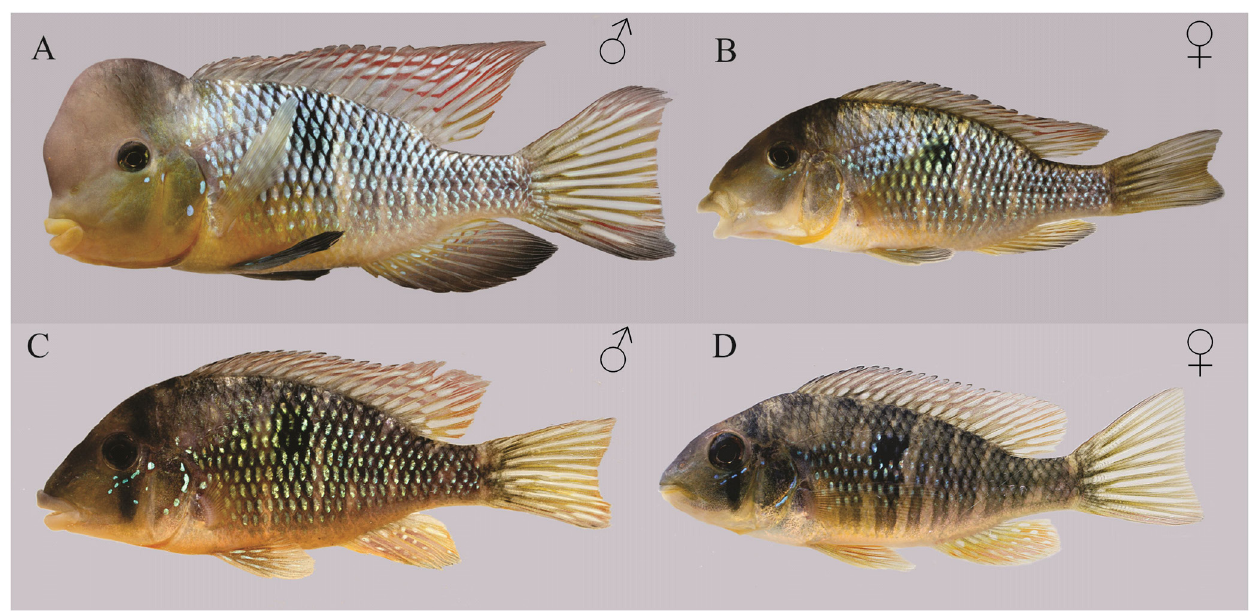
FIGURE 10 | Color pattern in the HBP and CSB. Gymnogeophagus labiatus . A. Male (117 mm SL; uncatalogued, Guaíba Lake near the mouth of the Celupa creek) and B . Female (104 mm SL; uncatalogued, Guaíba Lake, Barra do Ribeiro). C. Male (UFRGS 26425) and D. Female (UFRGS 26425), Camaquã